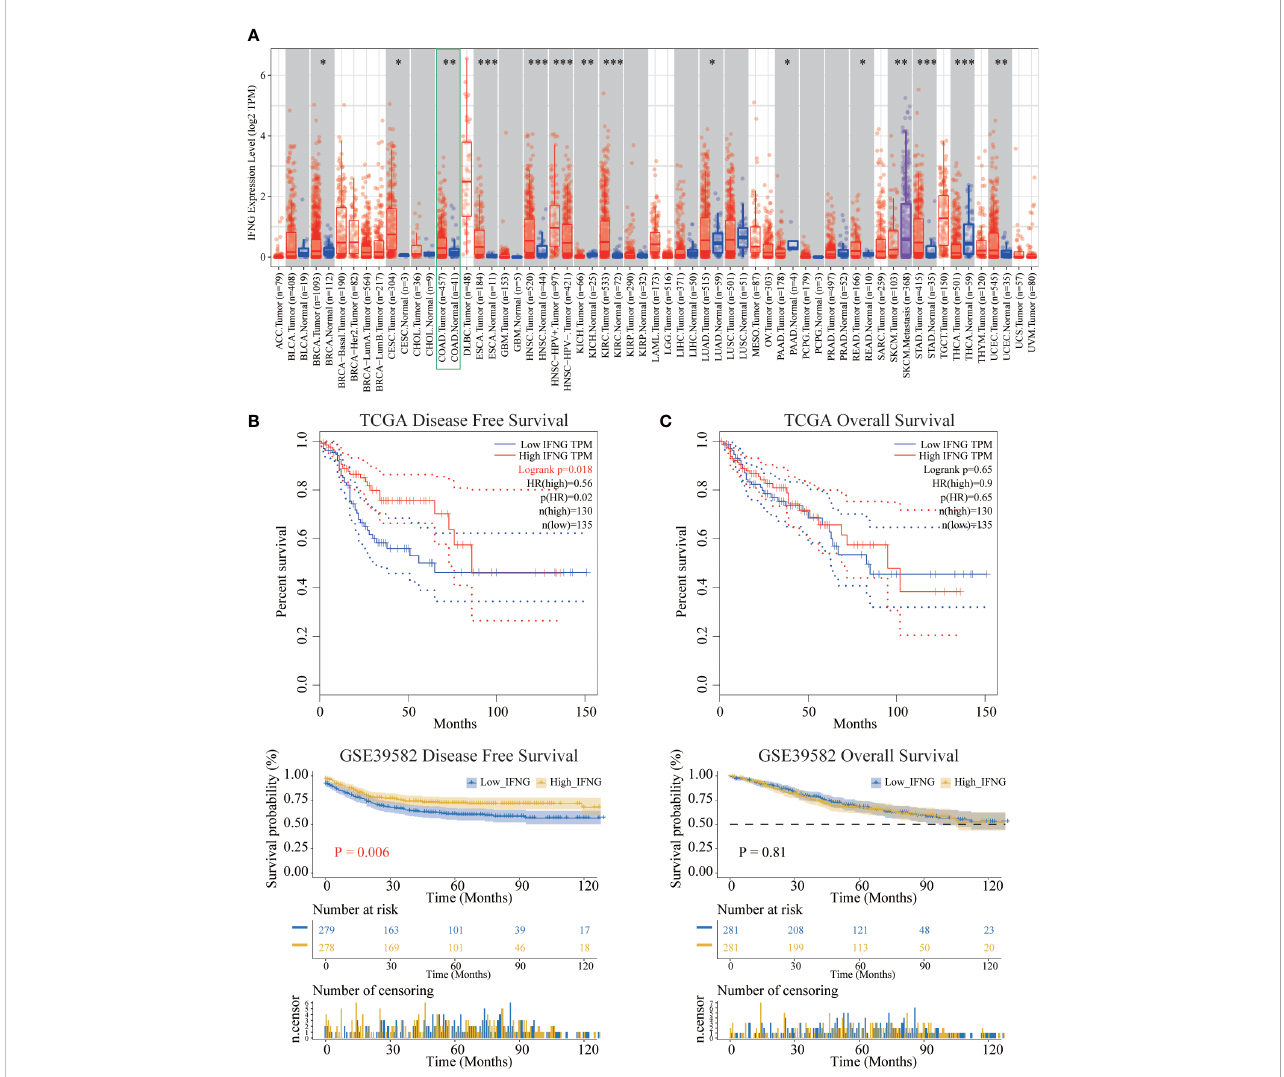
FIGURE 5 Differential expression and prognostic signi fi cance of IFNG. (A) In most types of TCGA pan-cancer, the expression of IFNG was signi fi cantly different between tumor and normal tissues. (* P -value < 0.05; ** P -value <0.01; *** P -value <0.001). (B) The disease-free survival (RFS) of the high IFNG group was signi fi cantly longer than that of the low IFNG group. (C) There was no difference in overall survival